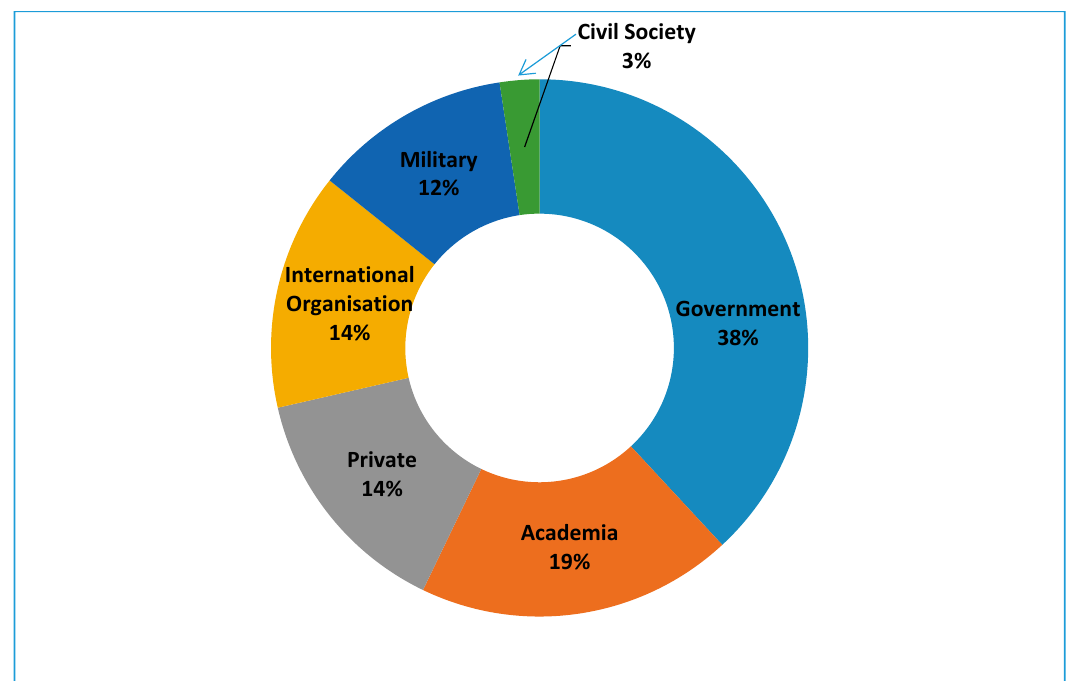
Figure 6. The distribution of the ARCSSTE-E’s survey respondents according to self-identified work sectors (N = 38).